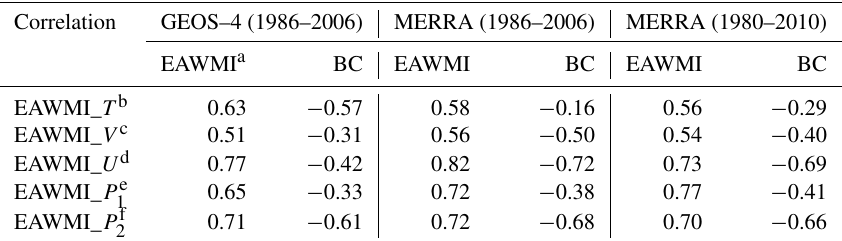
Table 1. Correlation coefficients among different definitions of the strength of the East Asian winter monsoon (EAWM), and between the EAWM index (EAWMI) and simulated December–January–February (DJF) mean surface BC concentrations averaged over eastern China (110–125 ◦ E, 20–45 ◦ N). Simulated BC concentrations are from model simulations VMETG4 and VMET, and corresponding monsoon indexes are calculated based on GEOS-4- and MERRA-assimilated meteorological